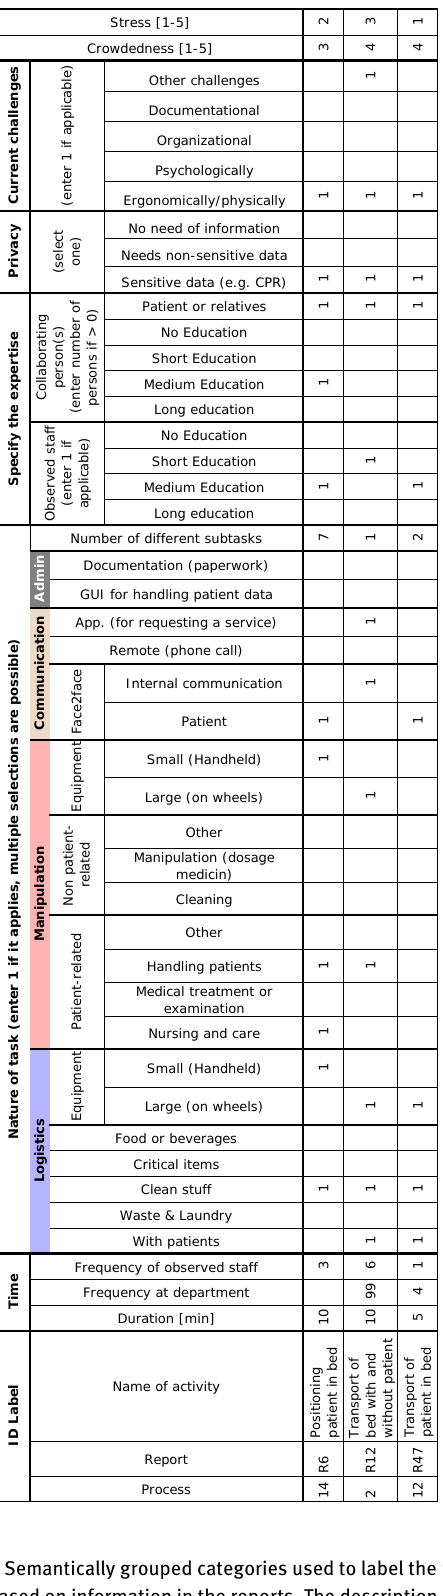
Figure 2: Semantically grouped categories used to label the pro- cesses based on information in the reports. The description corre- sponding to the examples are provided in Appendix A.